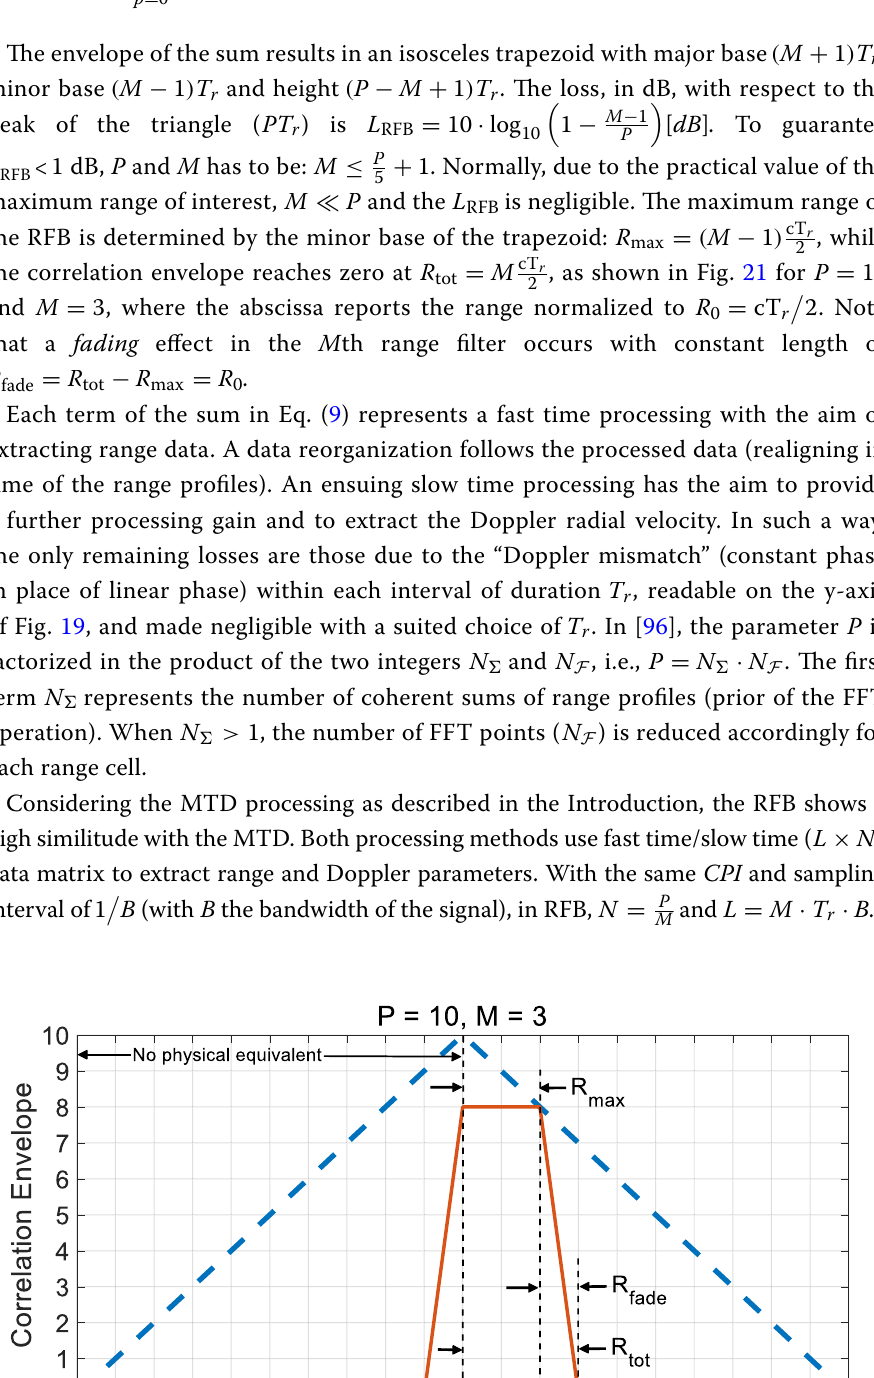
Fig. 21 Correlation envelope versus the normalized range: P = 10 , M = 3 , R 0 = cT r